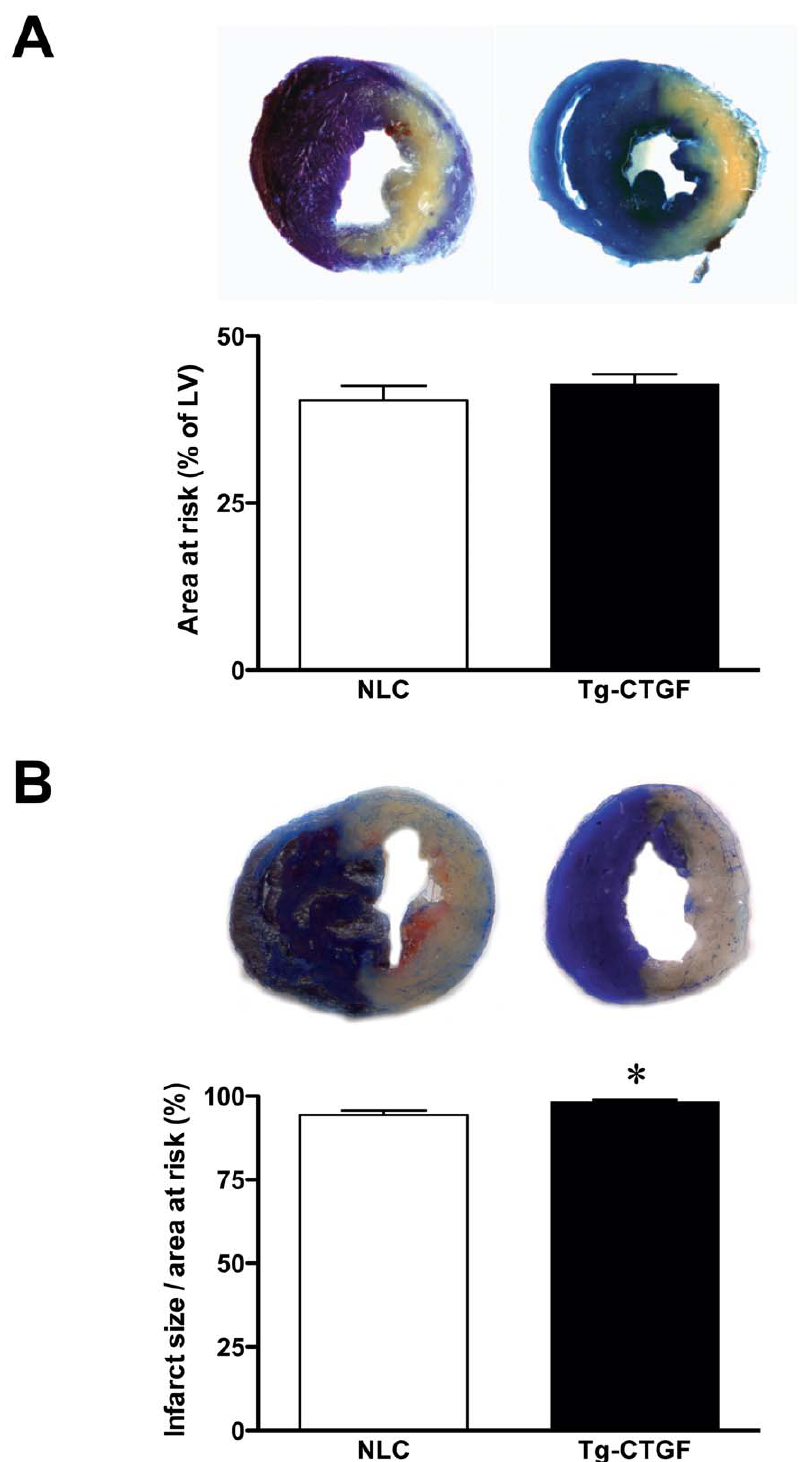
Figure 1. Area at risk and infarct size in NLC and Tg-CTGF mice subjected to ligation of LAD. A. Photomicrographs of representative myocardial sections of NLC and Tg-CTGF hearts perfused with Evans blue dye immediately after ligation of LAD. Histogram demonstrating area at risk in the left ventricles of NLC and Tg-CTGF mice determined by computerized planimetry after excision of the hearts. The data are mean 6 SEM of area at risk as percent of total LV area of NLC (n=8) and Tg-CTGF mice (n=8), respectively (40.4 6 2.1% vs. 42.7 6 1.6%, P =0.39). B. Photomicrographs of representative myocardial sections of NLC and Tg-CTGF hearts 24 hours after ligation of LAD and subsequent perfusion with Evans blue dye and myocardial staining with TTC. Histogram demonstrating infarct size (area of necrosis relative to area at risk) 24 hours after ligation of LAD, determined as described in the Materials and Methods section. The data are mean 6 SEM of NLC (n=6) and Tg-CTGF hearts (n=6). * P , 0.05 vs. NLC group.